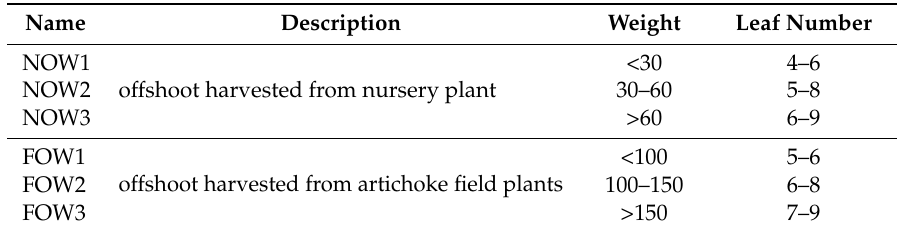
Table 1. Offshoot classification adopted in the